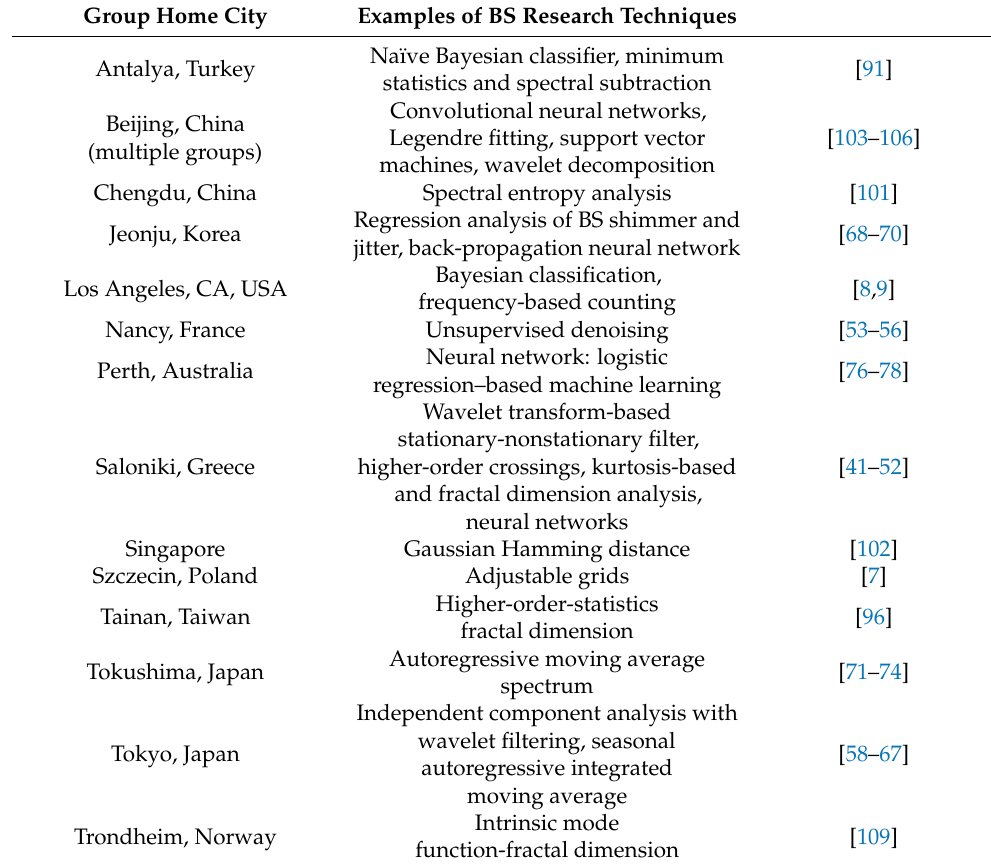
Table 1. Diversity of analytic techniques enabling or facilitating the identification of bowel sounds